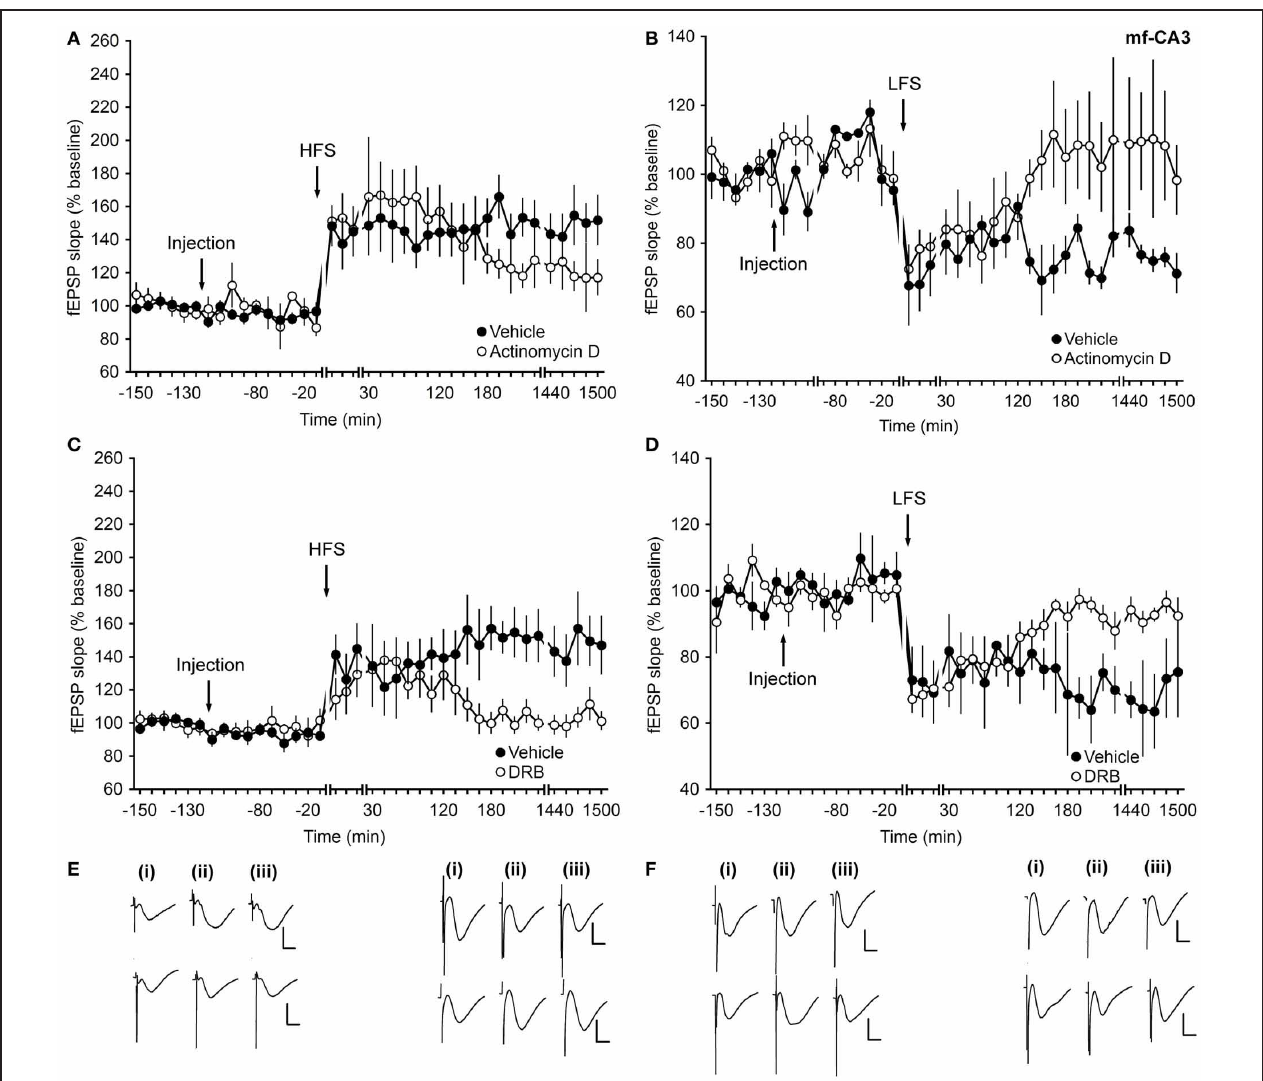
presence of vehicle (upper traces) or actinomycin D (lower traces). Vertical scale bar: 2mV, horizontal scale bar: 8ms. Analog traces in the right panel represent recordings taken (i) pre-LFS, (ii) 5min post-LFS, and (iii) 24h post-LFS in the presence of vehicle (upper traces) or Actinomycin D (lower traces). Vertical scale bar: 2mV, horizontal scale bar: 8ms. (F) Analog traces in the left panel represent fEPSP responses obtained (i) pre-HFS, (ii) 5min post-HFS, and (iii) 24h post-HFS in the presence of vehicle (upper traces) or DRB (lower traces). Vertical scale bar: 2mV, horizontal scale bar: 8ms. Analog traces in the right panel represent recordings taken (i) pre-LFS, (ii) 5min post-LFS, and (iii) 24h post-LFS in the presence of vehicle (upper traces) or DRB (lower traces). Vertical scale bar: 2mV, horizontal scale bar: